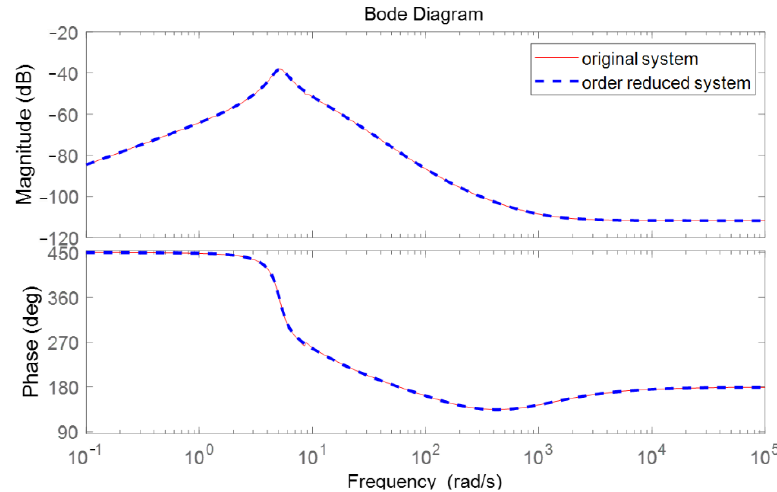
Figure 9. Bode diagram comparison of the order reduced system and original system of active power control loop.